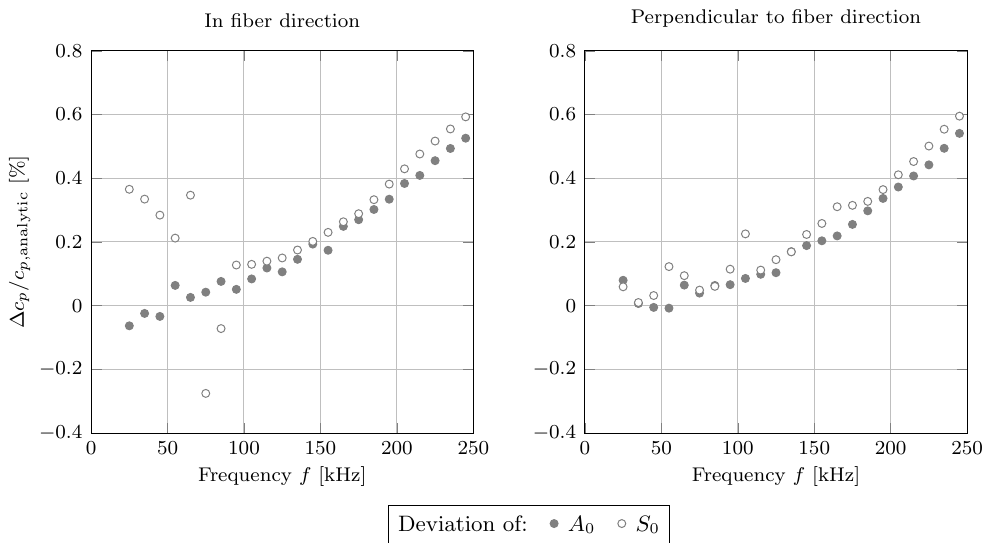
Figure 4. Deviation of the numerically and analytically determined dispersion diagrams in fiber direction ( left ) and perpendicular ( right ) to the fiber